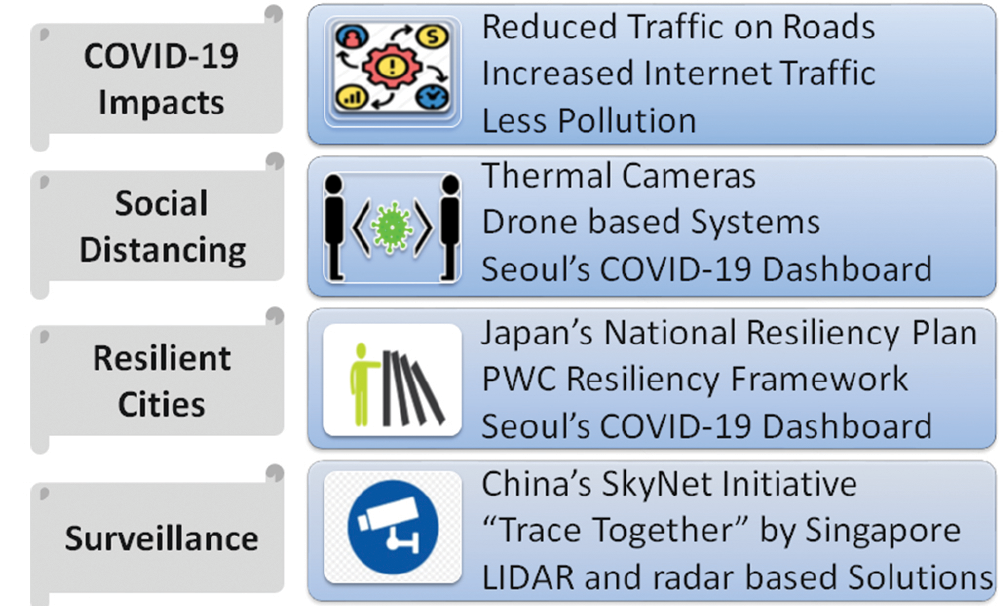
Figure 5. Recent Developments in Smart Cities in the Wake of